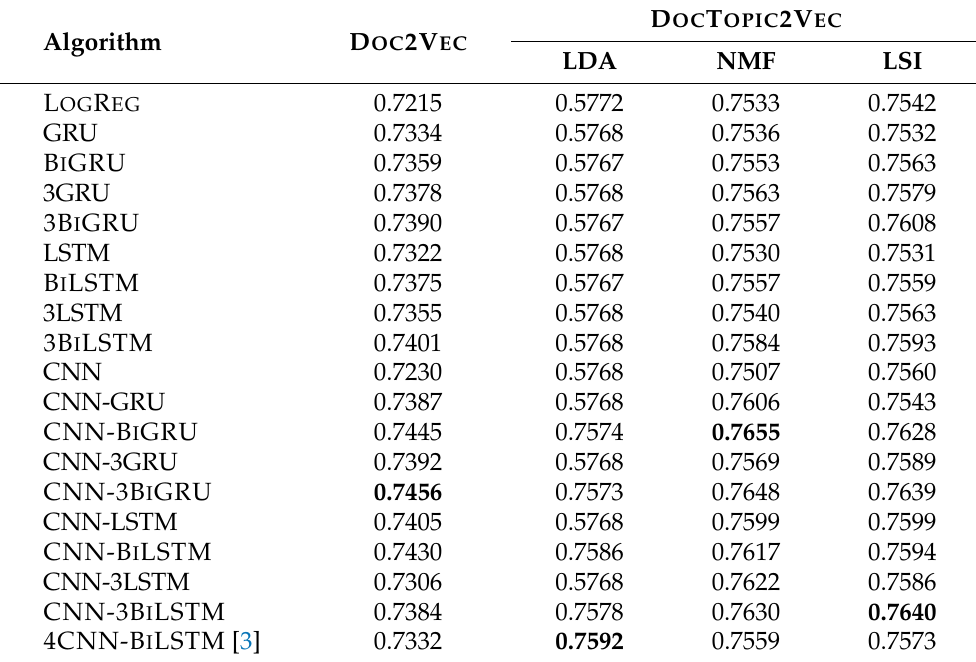
Table 7. Experiments using the W ORD 2V EC S KIP -G RAM embeddings of size 128. (Note: Bold